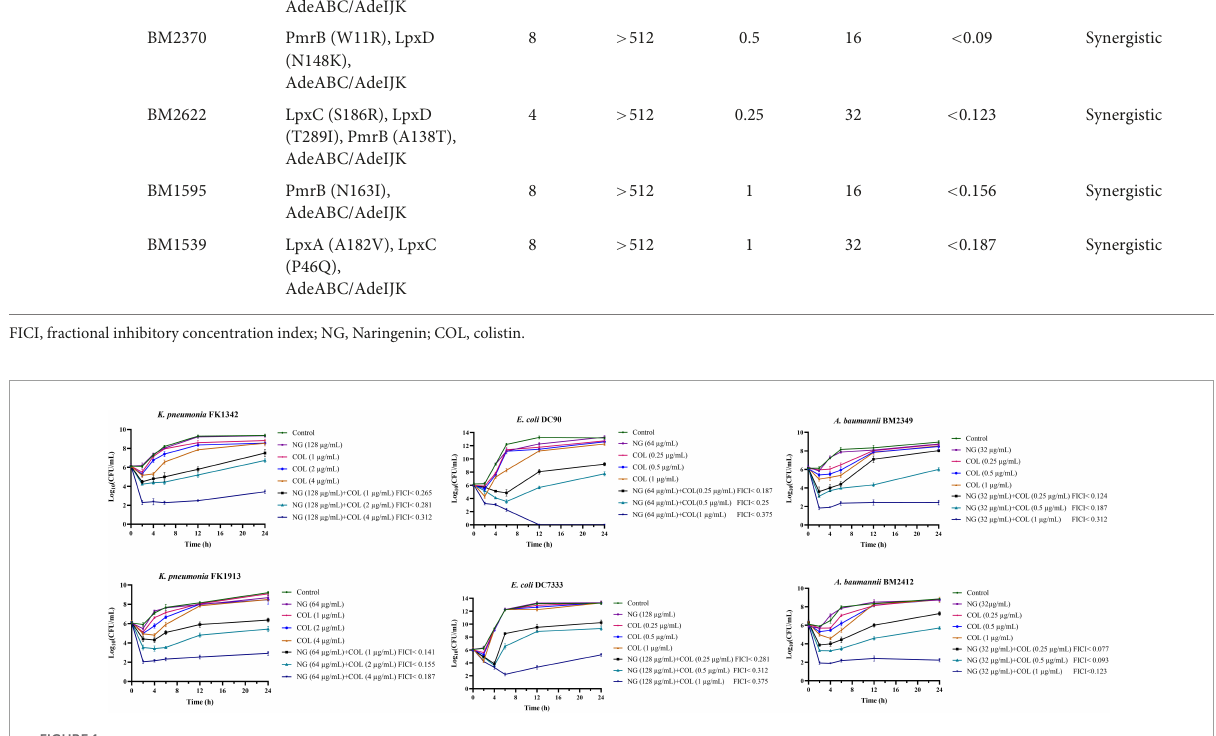
FIGURE1 Colistin and naringenin time-killing curves against colistin-resistant Klebsiella pneumonia , colistin-resistant Escherichia coli , and colistin-resistant Acinetobacter baumannii when used alone or in combination. Naringenin (NG) and colistin